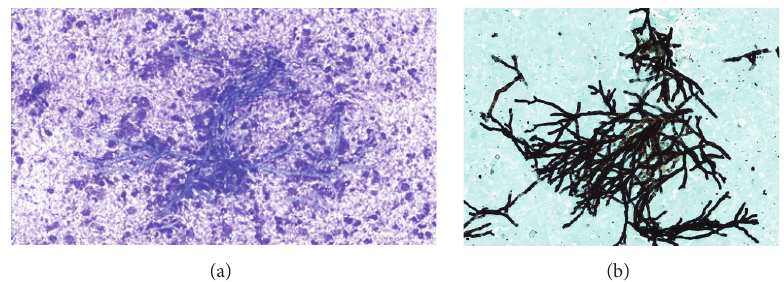
Figure 1: (a) 45-degree angle branching fungal hyphaes within a necroinflammatory background (May Gr¨unwald Giemsa Stain, × 400). (b) Septated and branching fungal hyphaes consistent with aspergillosis (Grocott Methenamine Silver stain, ×